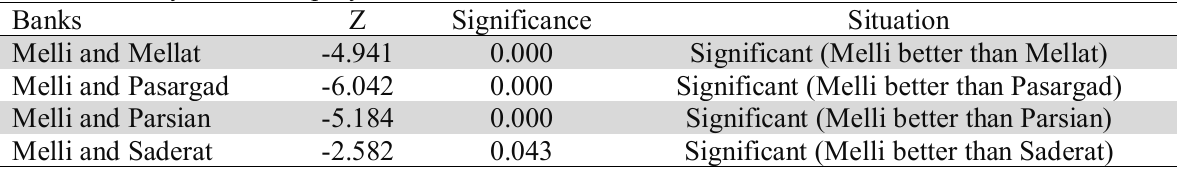
Mann-Whitney test for employee interaction Banks